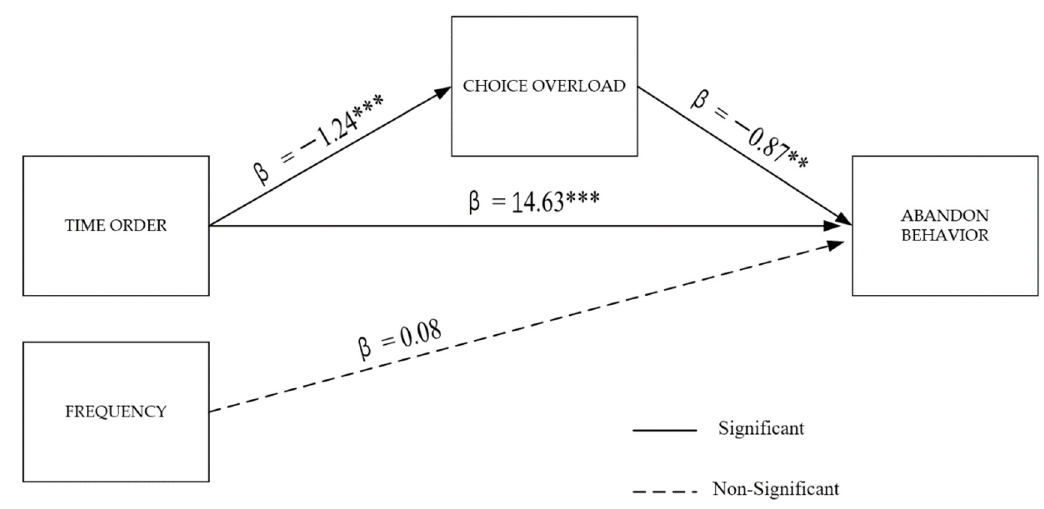
Figure 3. Model statistical diagram. ** p < 0.01, *** p < 0.001.